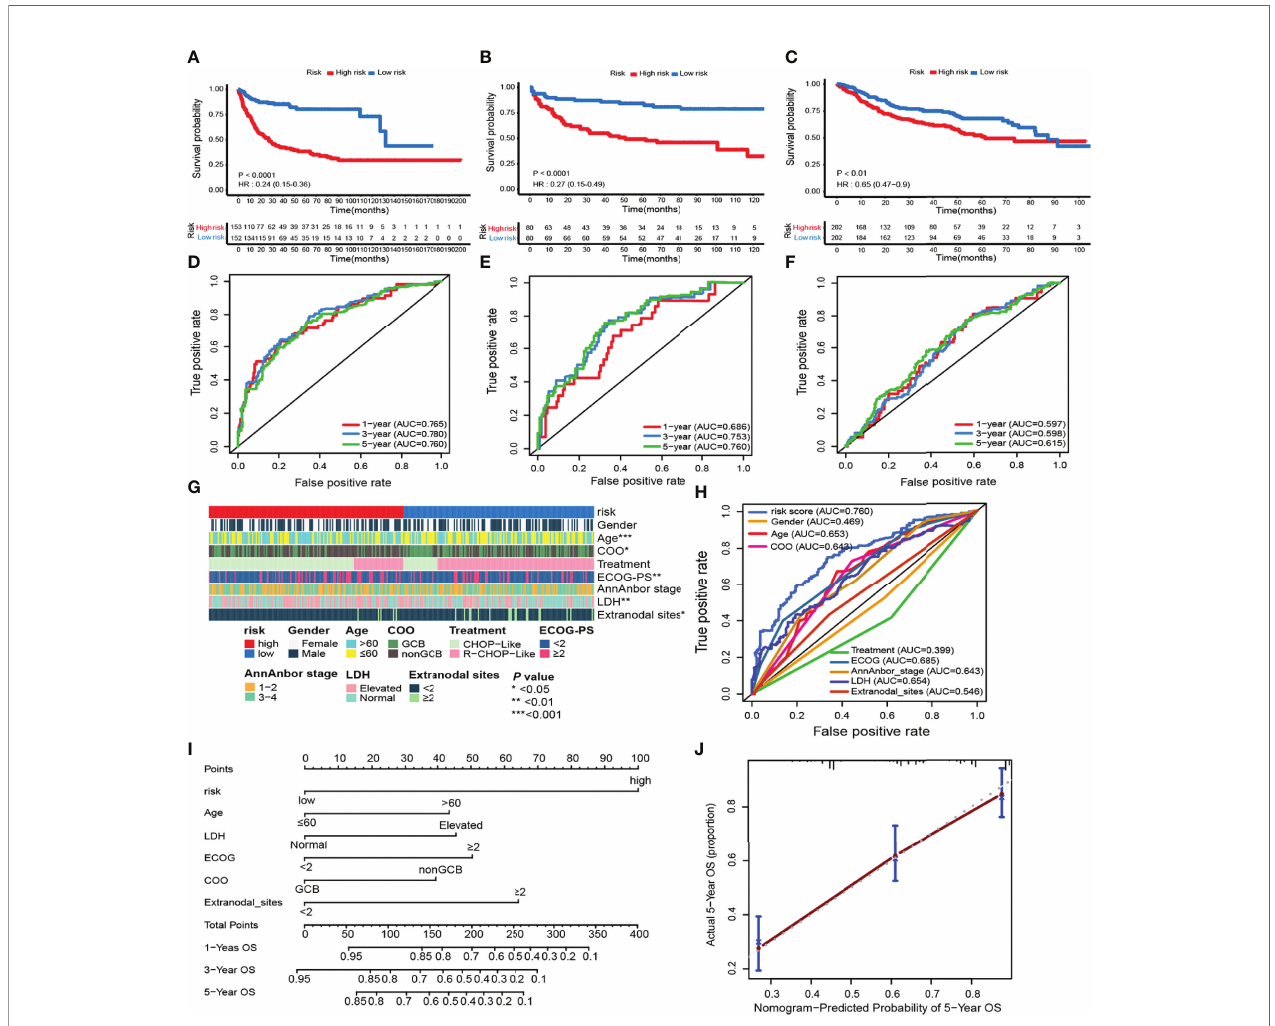
FIGURE 3 | Prognostic value of the risk model including 9 epigenetic-related lncRNAs. (A – F) Kaplan – Meier survival curves of the high- and low-risk groups and time-dependent receiver operating characteristic (ROC) curves at 1-, 3-, and 5-year overall survival (OS) in the training (GSE10846) and validation (TMUCIH and GSE31312) cohorts. (G) Heatmap showing the comparison of the clinicopathological characteristics of DLBCL patients in the high- and low-risk GSE10846 groups. (H) Time-dependent ROC curve analyses for predicting OS at 5 years with clinicopathological characteristics. (I) The nomogram was constructed using high and low ELncSig scores, age, LDH, GCB vs. non-GCB, ECOG, and extranodal sites to predict 1-, 3-, and 5-year survival. (J) Calibration plots for the probability of 5-year survival in the training